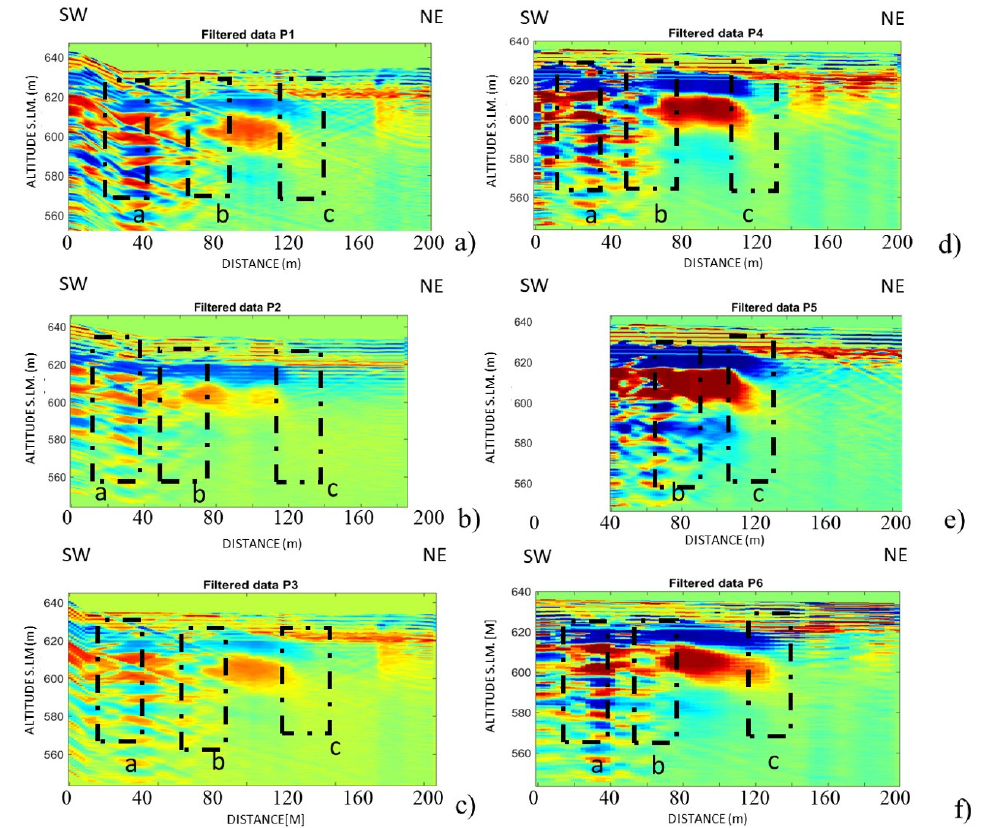
Figure 12. ( a – f ) Filtered data of each considered GPR profile (P1–P6, see trace in Figure 3). The black dot-dashed rectangles a–c highlight the variations of the electromagnetic response recorded along the profiles imputable to the presence of the expected geological structures.